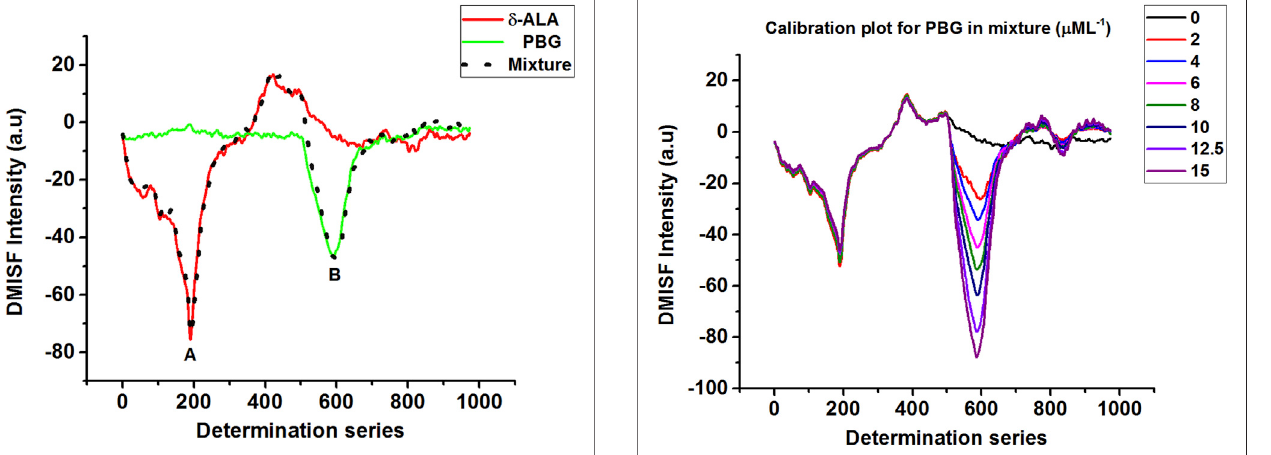
FIGURE 6 | DMISF spectra of 1.5 μ mol L − 1 δ -ALA with increasing amount of PBG 0 – 15 μ mol L − 1